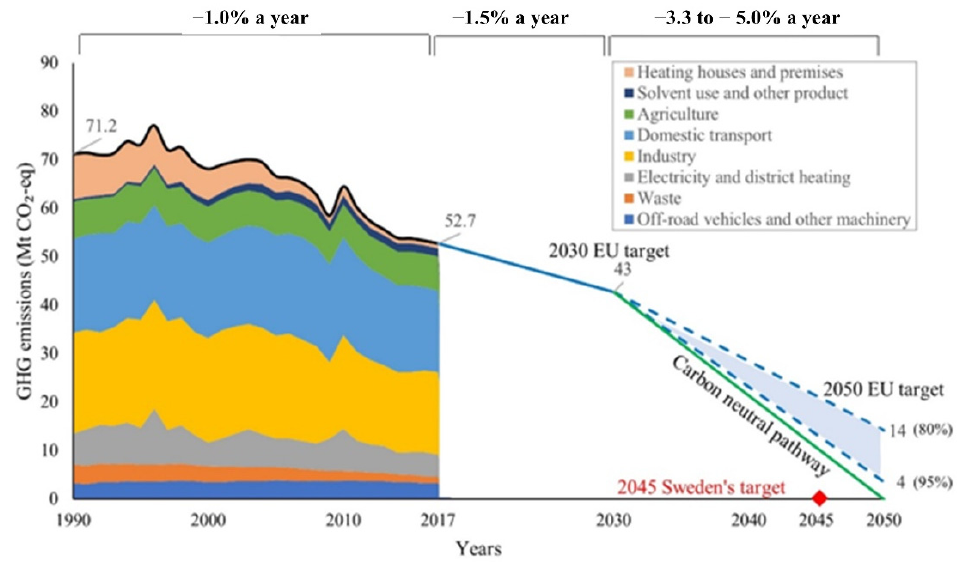
Figure 3. Historical greenhouse gas emissions by sector and the target of net-zero emissions. Source (historical data): Swedish Environmental Protection Agency [45].